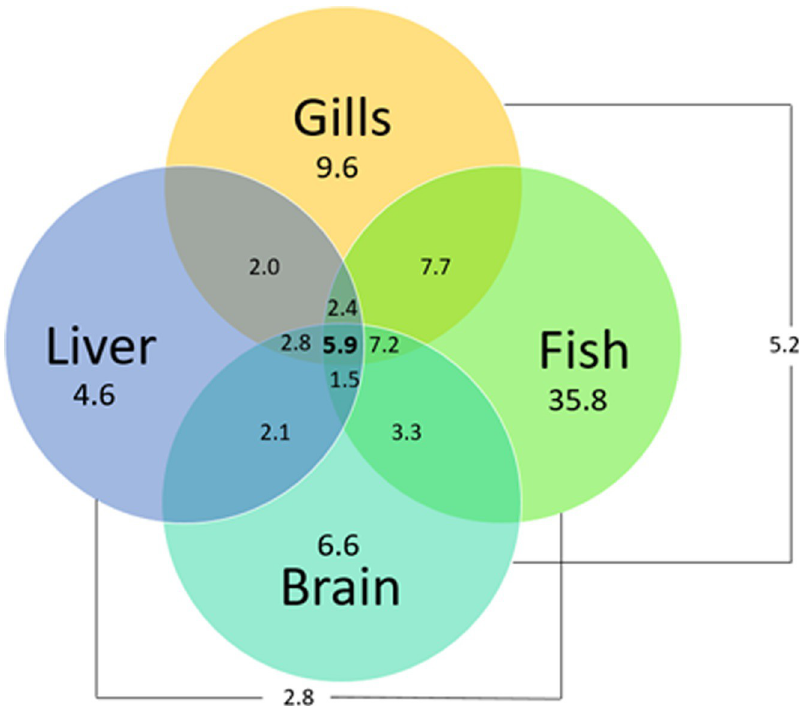
Fig 6. Venn diagram showing specific and overlapping of detected features (m/z, R T ) achieved with the RPLC(ESI +)/HILIC(ESI-) analyses in brain, gills, liver and fish (expressed in % of total features).